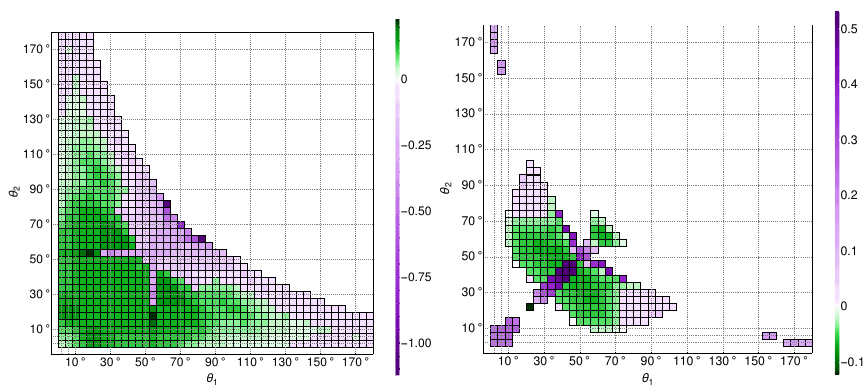
Figure 1. ∆ ( θ 1 ,θ 2 ) as a function of the polar angles ( θ 1 ,θ 2 ) of the two outgoing proton momenta at E = 13 MeV (left) and E = 65 MeV